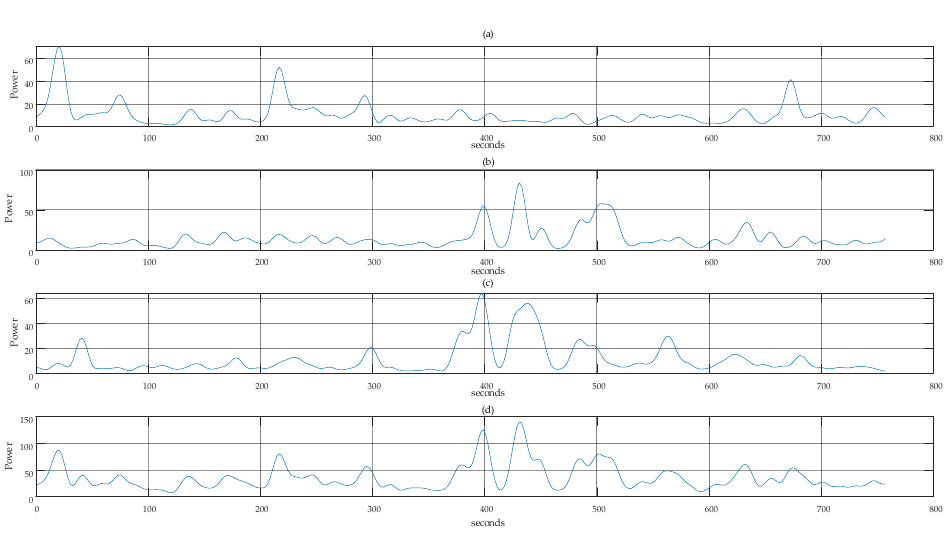
Figure 7. Band power separation example from F4 electrode. ( a ) Theta band power, ( b ) Alpha band power, ( c ) Beta band power, ( d ) Total band